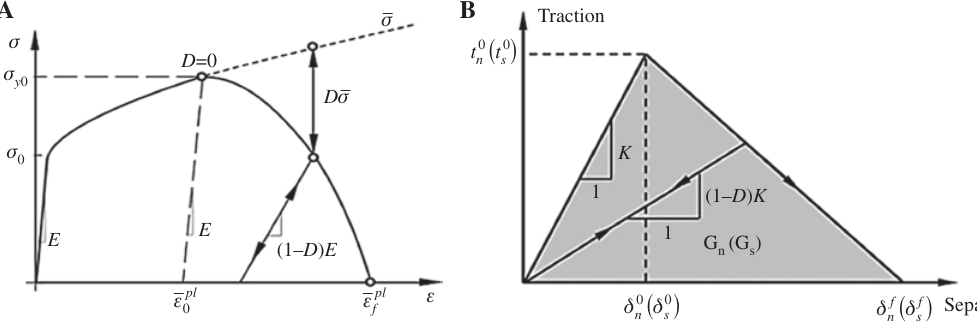
Figure 5: (A) Stress-strain behavior of the polymeric matrix. (B) Traction-separation law of the cohesive